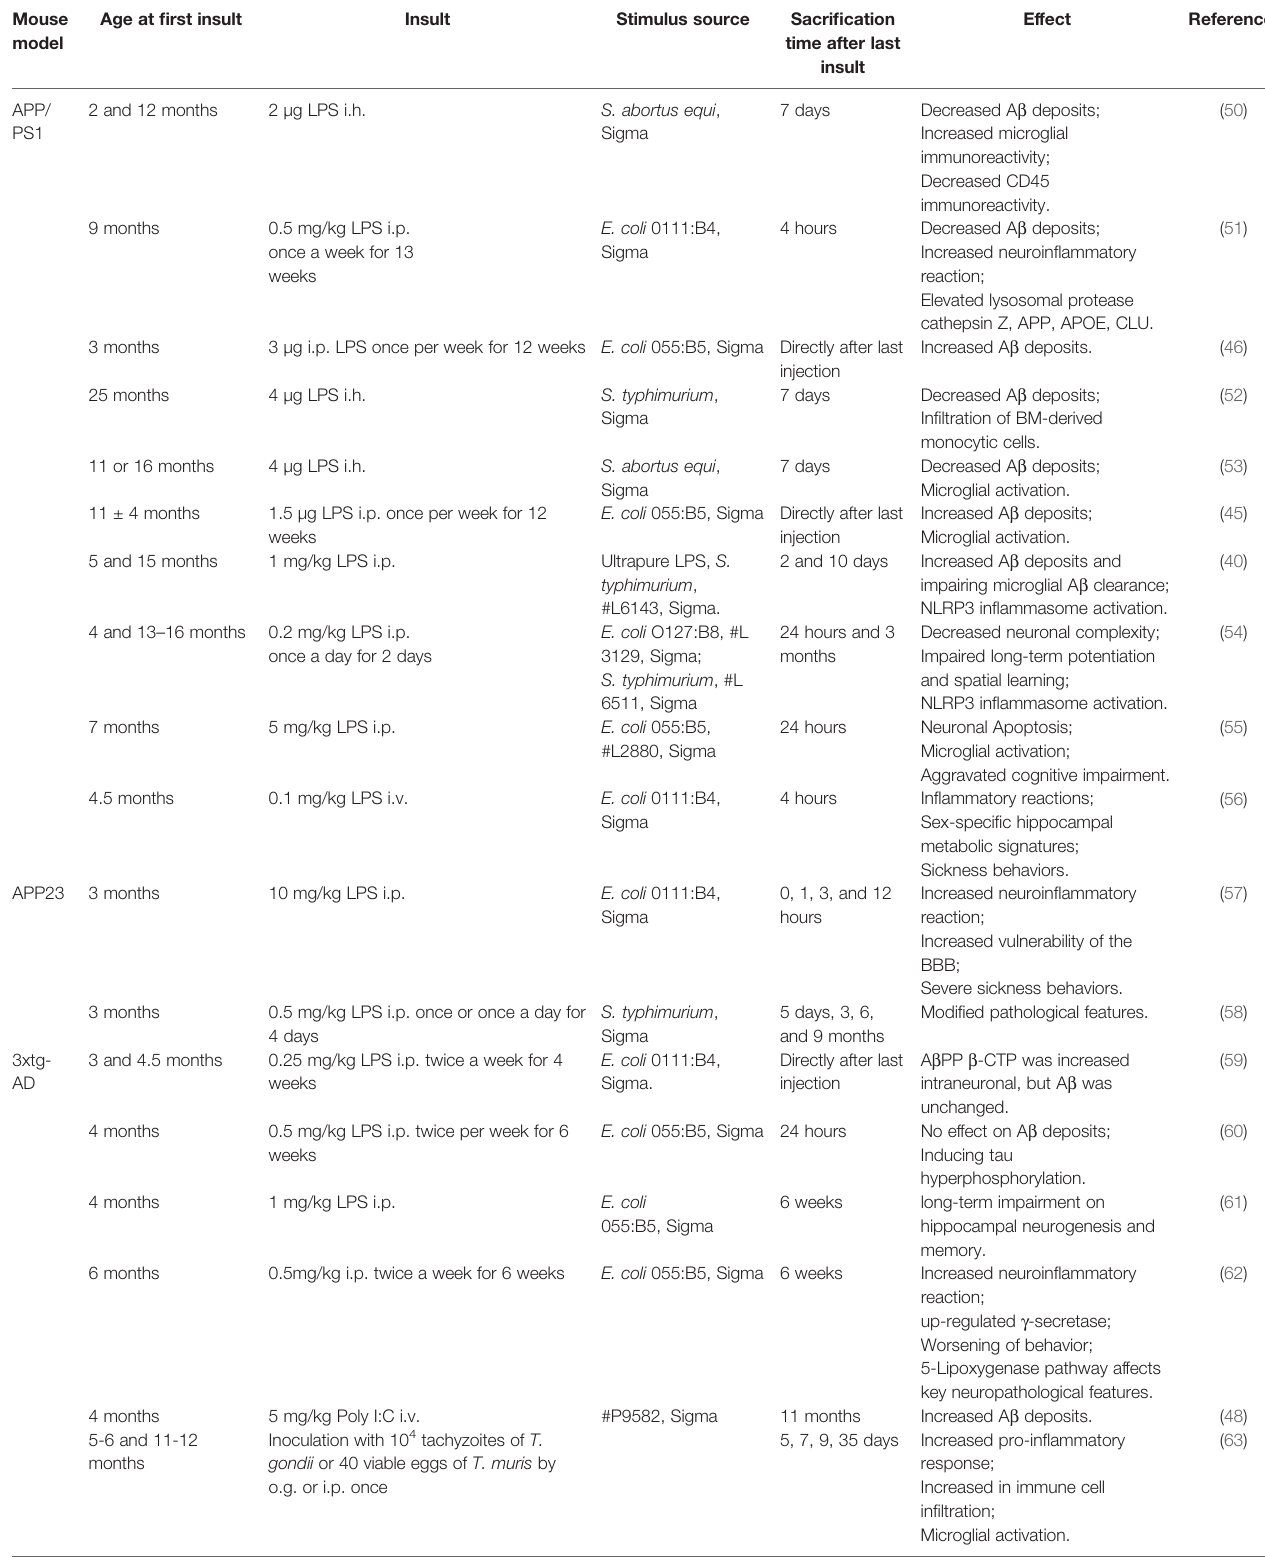
TABLE 1 | Preclinical studies on the effect of systemic in fl ammation in mouse models for AD. Mouse